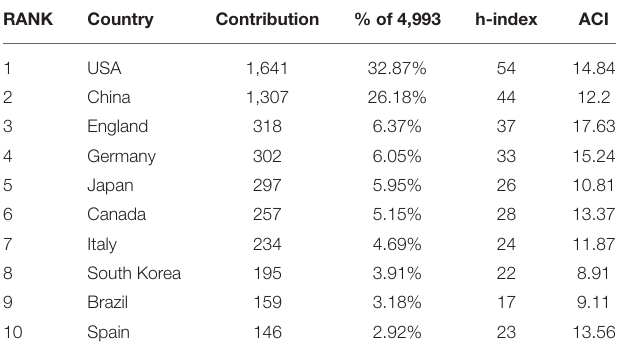
TABLE 1 | The top 10 most productive countries from 2017 to